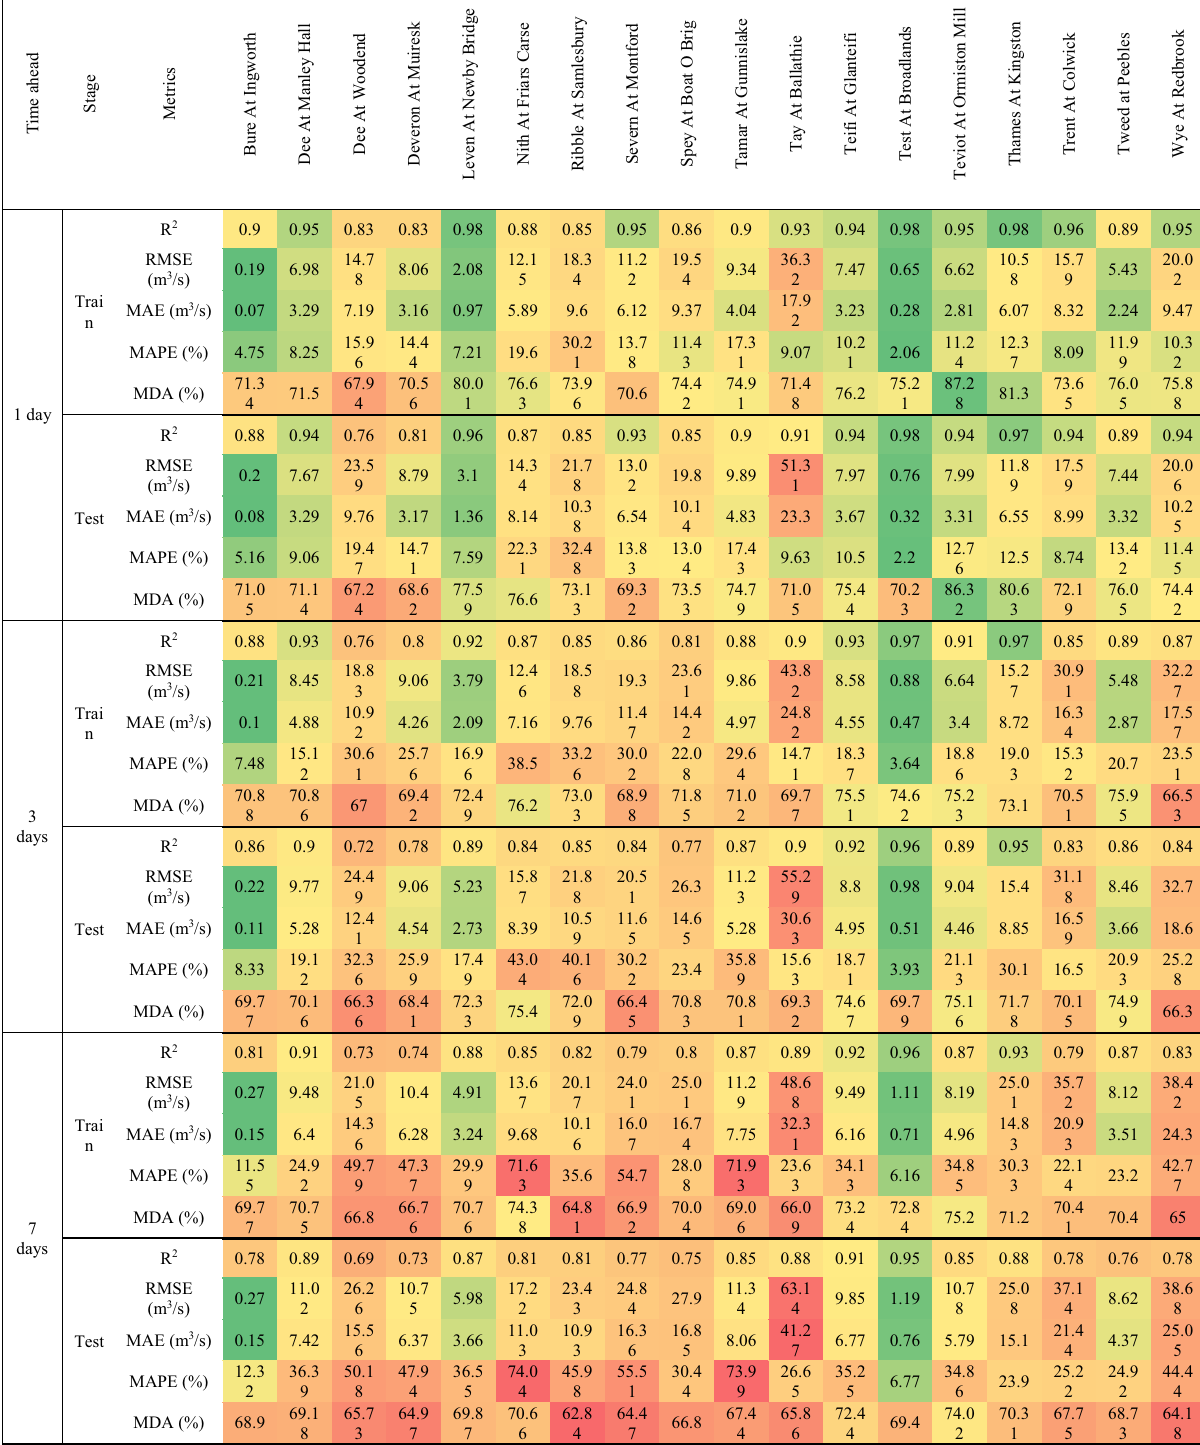
Table 4. Evaluation metrics for MLP-RF